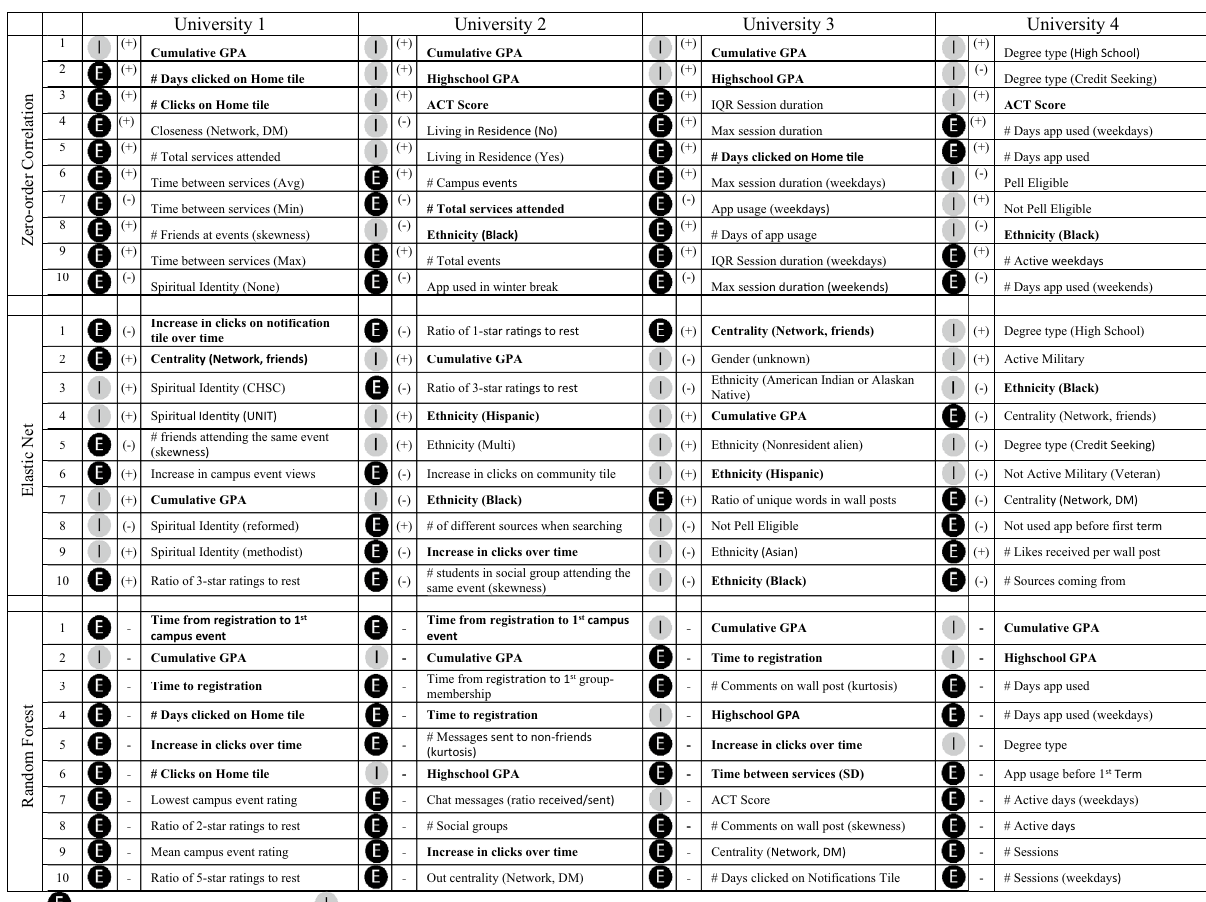
Table 3. Overview of the ten most important features in the elastic net (top) and random forest (bottom) benefit more from being embedded in a strong social network than majority students who do not face the same barriers and are likely to have a stronger external support network. The bottom of Table 3 displays the 10 most important features in the elastic net and random forest models (i.e., highest permutation variable importance). Supporting the findings reported in RQ1, the zero-order correlations confirm that both institutional and behavioral engagement features play an important role in predicting student retention. Aligned with prior work, students’ performance (measured by GPA or ACT) repeatedly appeared as one of the most important predic- tors across universities and models. In addition, many of the engagement features (e.g., services attended, chat messages network centrality) are related to social activities or network features, supporting the notion that a student’s social connections and support play a critical role in student retention. In addition, the extent to which students are positively engaged with their institutions (e.g., by attending events and rating them highly) appears to play a critical role in preventing dropout. RQ3: How well do the predictive models generalize across universities? To test the generaliz- ability of our models across universities, we used the predictive model trained on one university (e.g., University 1) to predict retention of the remaining three universities (e.g., Universities 2–4). Figures 3A,B display the AUCs across all possible pairs, indicating which university was used for training (X-axis) and which was used for test- ing (Y-axis, see Figure S1 in the SI for graphs illustrating the findings for F1, TNR and TPR). Overall, we observed reasonably high levels of predictive performance when applying a model trained on one university to the data of another. The average AUC observed was 63% (for both the elastic net and the random forest), with the highest predictive performance reaching 74% (trained on University 1, predicting University 2), just 1%-point short of the predictive performance observed for the prediction from the universities own model (trained on University 2, predicting University 2). Contrary to the findings in RQ1, the random forest models did not perform better than the elastic net when making predictions for other universities. This suggests that the benefits afforded by the random forest models capture complex interaction patterns that are somewhat unique to each university but might not generalize well to new contexts. The main outlier in generalizability was University 4, where none of the other models reached accuracies much better than chance, and whose model produced